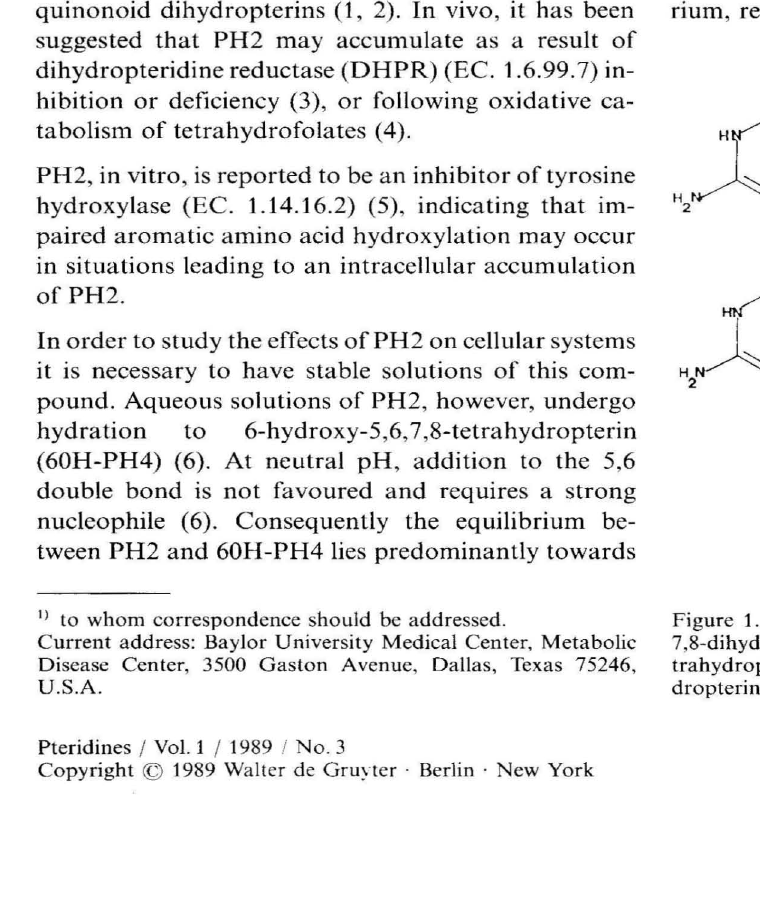
Figure 1. Formation of 7,8-dihydroxanthopterin (XH2) from 7,8-dihydropterin (PH2). 1= PH2, II = 6-hydroxy-5,6,7,8-te trahydropterin (60H-PH4), III = quinonoid-6-hydroxy dihy dropterin, IV =